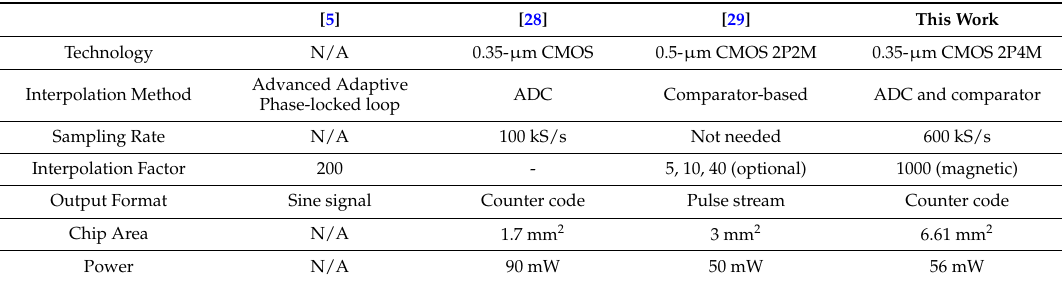
Figure 17. The result of the displacement error in 10 mm. Table 1. Performance comparison with other interpolation